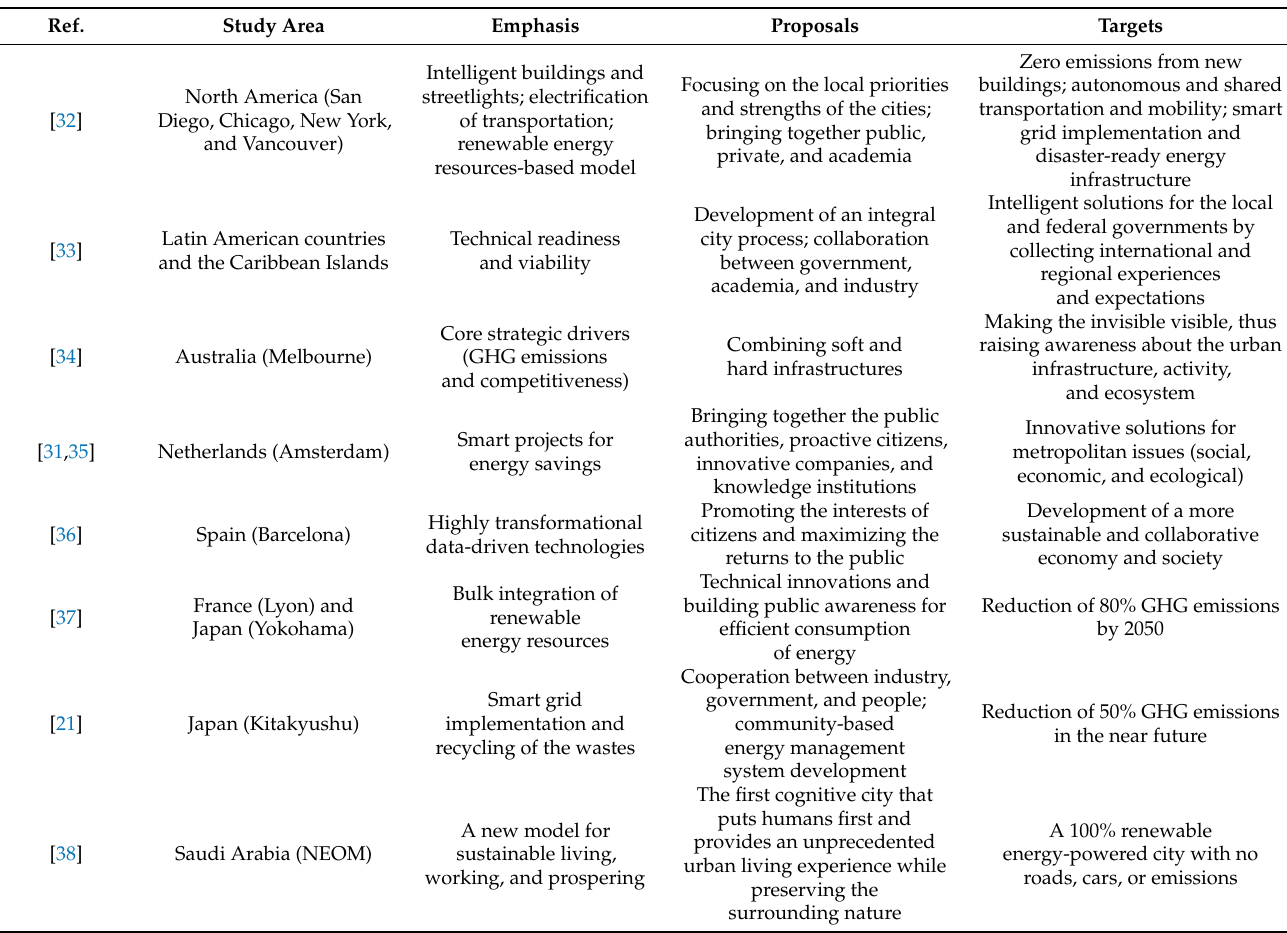
Table 1. Smart city concept